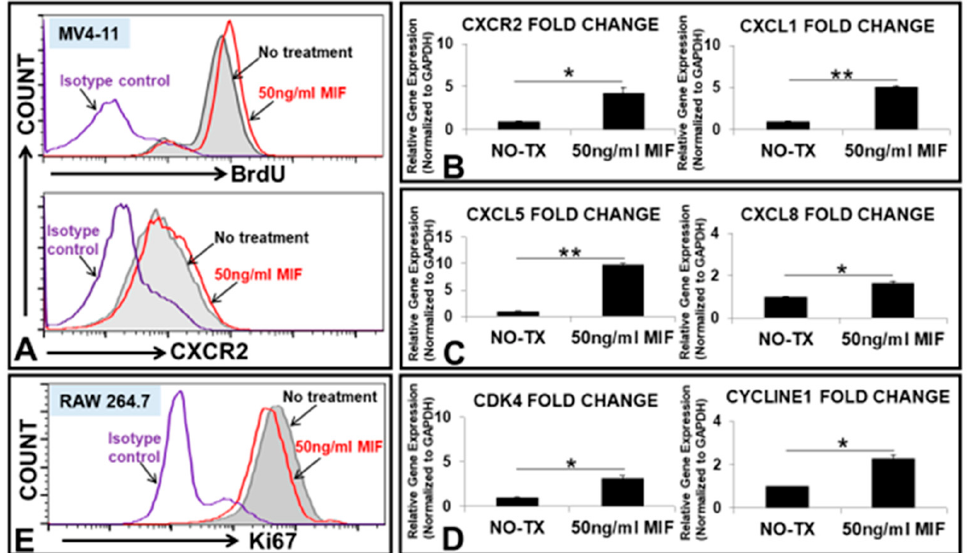
Figure 2. MIF promoted the proliferation of MV4-11 through up-regulating the expressions of CXCR2, cytokines and cell division proteins in vitro. ( A ) Representative flow cytometry (FC) plots of BrdU expression (upper histogram) and CXCR2 expression (lower histogram) in 50 ng/mL MIF- treated MV4-11 cells or non-treatment control (without adding MIF) after 2 days in vitro; ( B ) Data show the change of mRNA expressions of CXCR2 gene and CXCL1 chemokine gene in MV4-11 cells at 50 ng/mL MIF in vitro; ( C ) Data show the change of mRNA expressions of CXCL5 and CXCL8 chemokine genes in MV4-11 cells at 50 ng/mL MIF in vitro; ( D ) Data show the change of mRNA expressions of CDK4 and CYCLIN E1 genes in MV4-11 cells at 50 ng/mL MIF in vitro; ( E ) Representative FC histogram plot of Ki-67 expression in RAW264.7 experimental groups after 2 days in vitro; Red curve indicates the treated group with 50 ng/mL MIF, showing less expression of Ki-67 when compared to the non-treatment control (gray curve); * p < 0.05, ** p < 0.01.